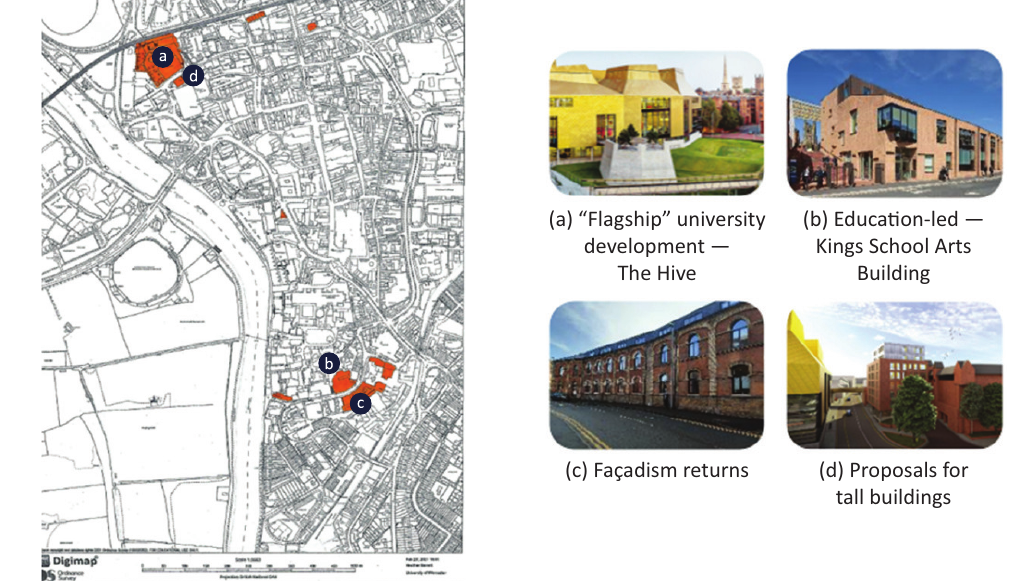
Figure 7. The location of new build development proposals between 2008—2021: Conservation in the “age of austerity.” Sources: (a) University of Worcester (2019; image), (b) base‐map on the left by Digimap, (c) annotations and photos by the author, and (d) Barnett (2019;